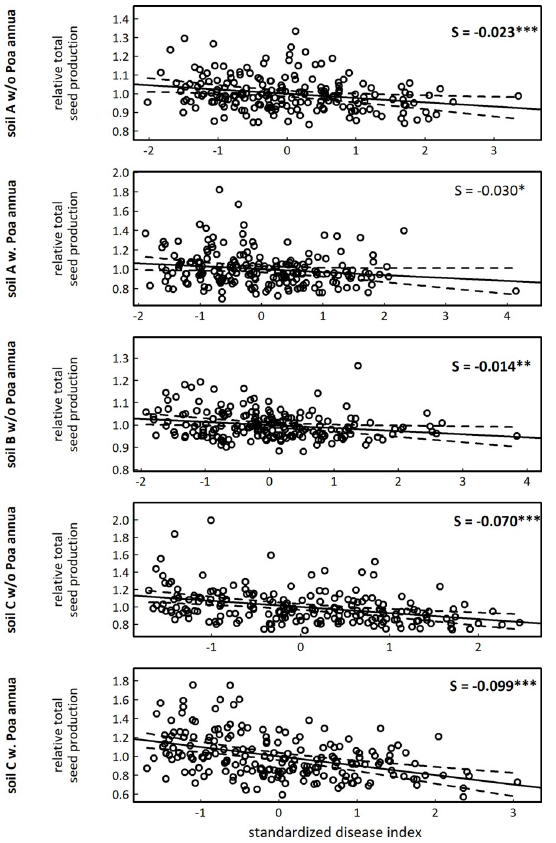
Fig 3. Genotypic selection analysis between relative total seed production and standardized disease index with selection differential (S) within each micro-habitat for which disease index was significantly heritable. Each dot corresponds to the Best Linear Unbiased Estimator (BLUE) for disease index of one of the 195 accessions. ‘w/o’: absence of P . annua , ‘w.’: presence of P . annua . The solid line corresponds to the fitted regression line, whereas the dashed lines delimit the band of 99% confidence intervals. ��� P < 0.001, �� P < 0.01, � P < 0.05. Bold P values indicate statistically significant results after a Bonferroni correction for multiple comparisons. Note that the scale for the x and y axes are different among the five